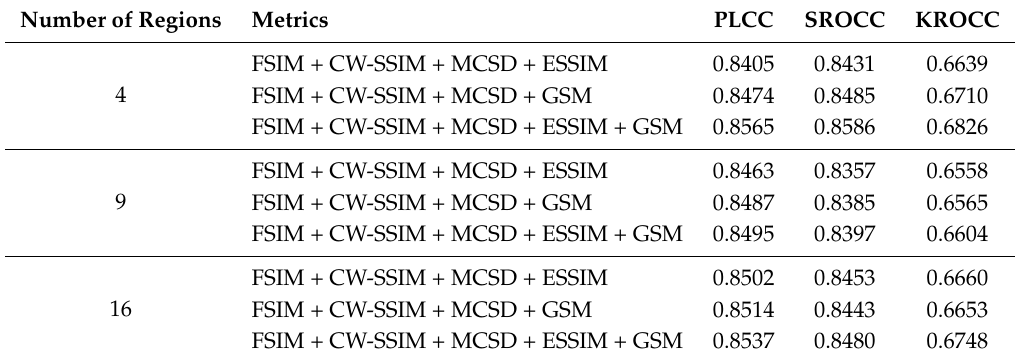
Table 4. The correlation coefficients obtained for 107 images using the “best” combinations of four and five elementary metrics assuming the division into 4, 9, and 16